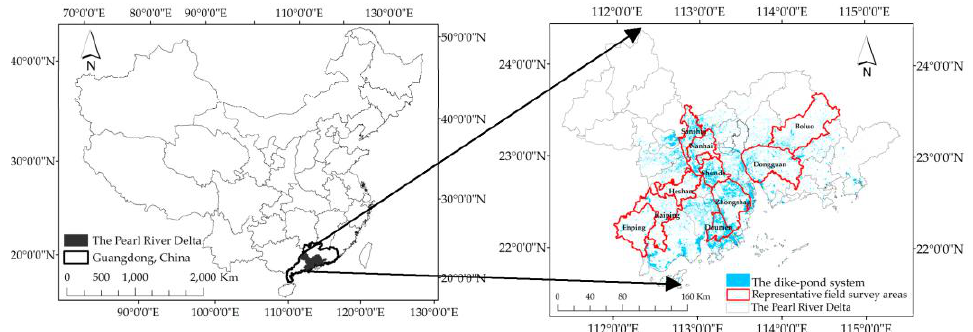
Figure 3. The representative field survey areas in the Pearl River Delta.